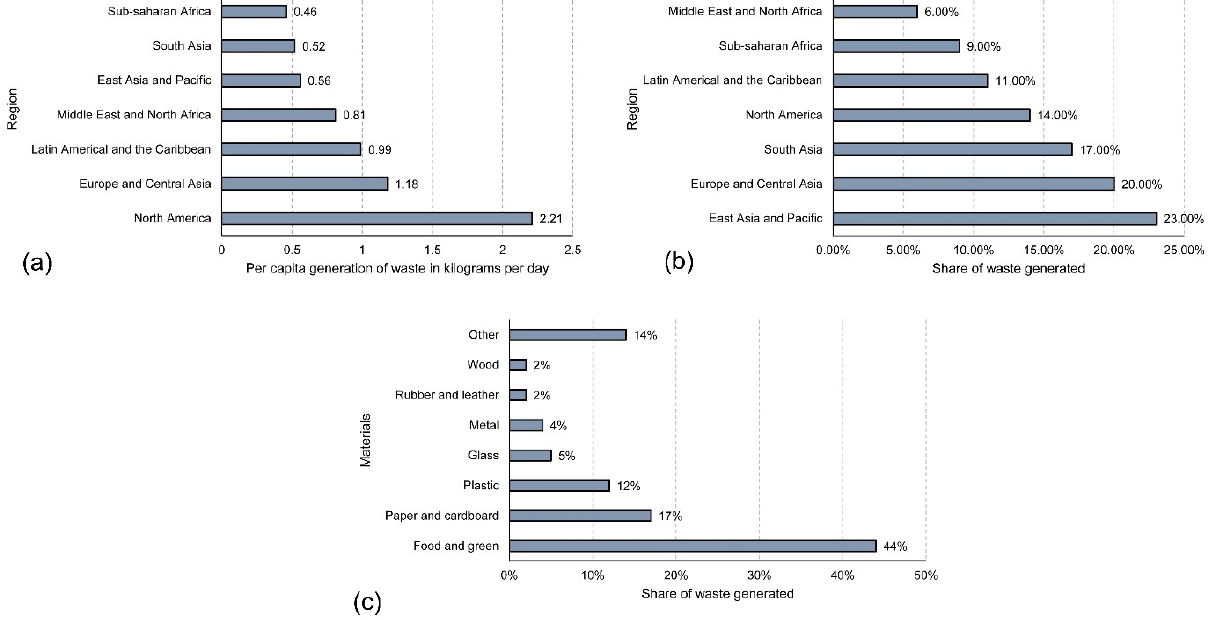
Figure 2. ( a ) Average per capita municipal solid waste generation by region in 2016, ( b ) share of waste generated by region in 2016, and ( c ) global municipal solid waste generation share of materials in 2016 (graphs generated using data from Reference [21]).